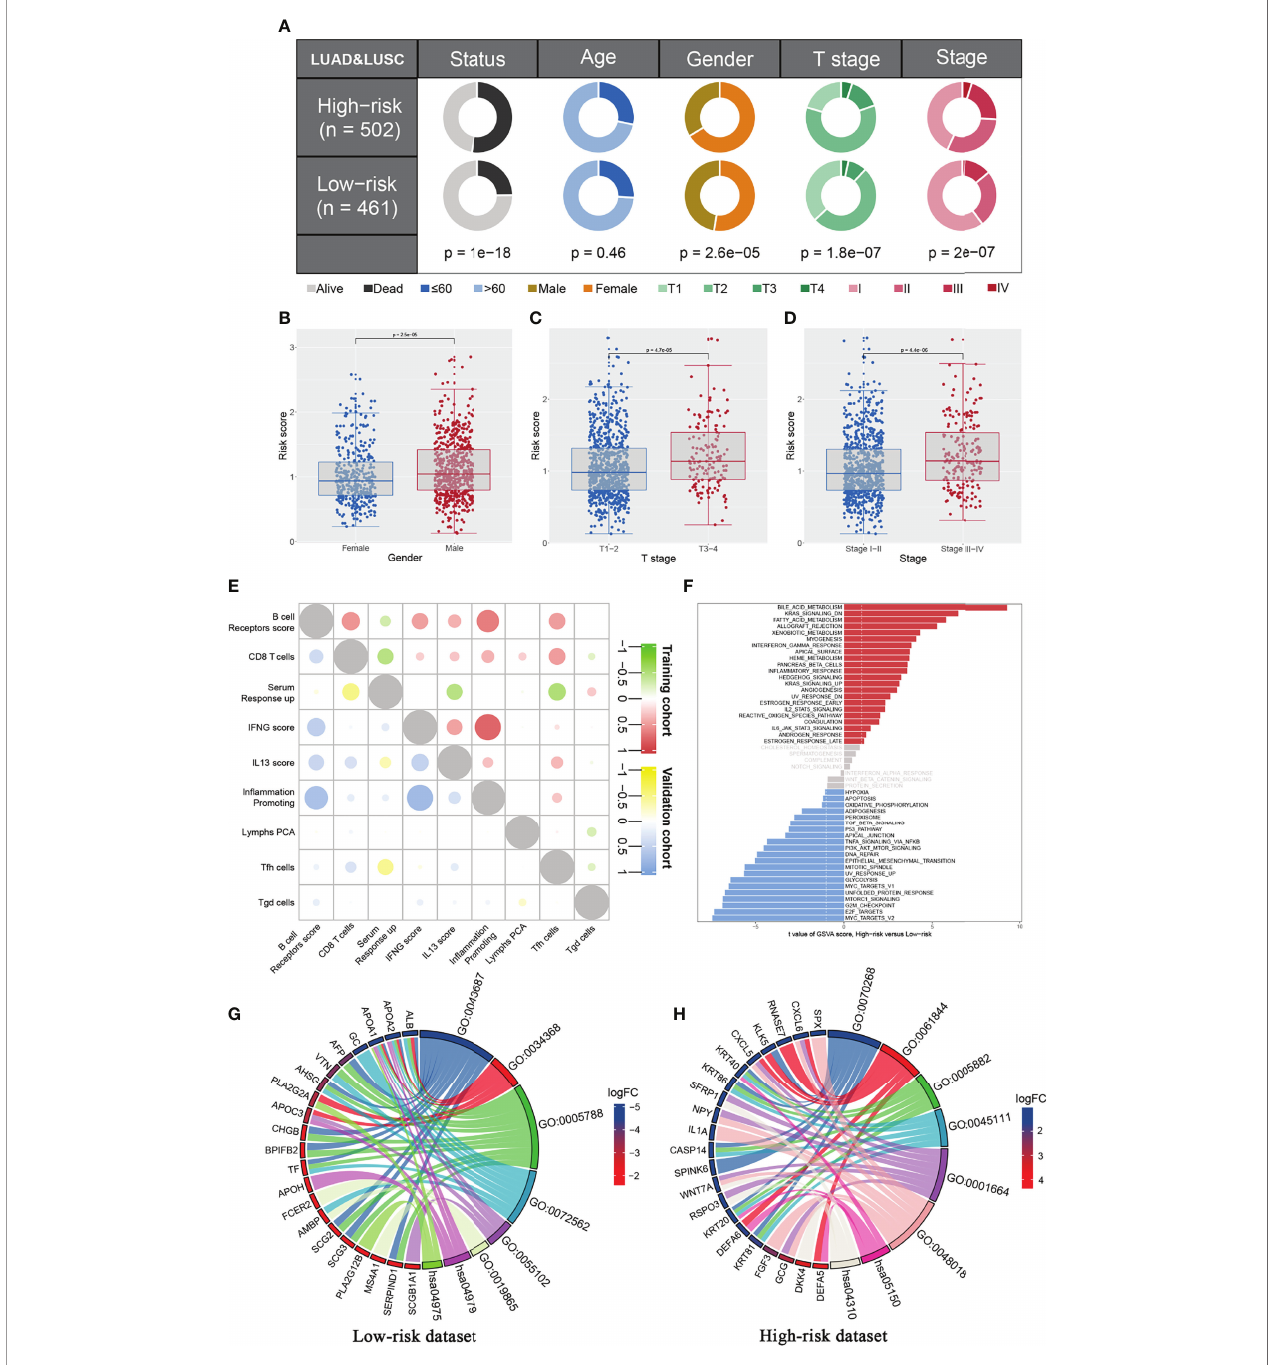
FIGURE 4 | Clinical correlation and biological effect of IRS model. (A) The patients in high risk group have a higher percentage of more aggressive clinical features compared with the low risk patients, including T stage and clinical stage; (B – D) The IRS level between different group (Male vs. Female, T3-4 vs. T1-2, Stage III-IV vs. Stage I-II); (E) Co-expression immune terms of model immune terms; (F) GSEA analysis was performed to explore the biological pathway difference between high and low IRS group; (G, H) GO and KEGG pathway enrichment in low and high risk